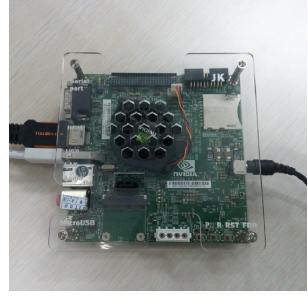
Figure 4. NVIDIA Jetson TK1 embedded development board.